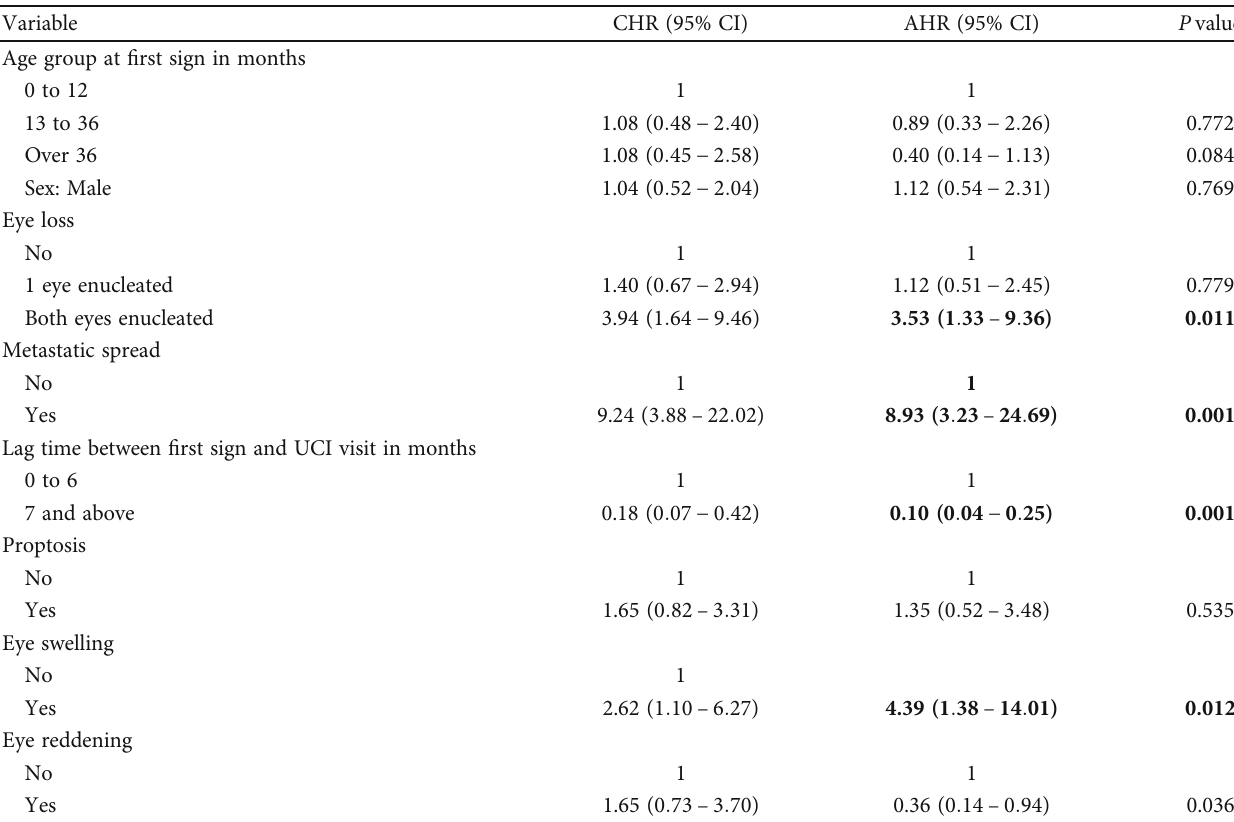
Figure 3: Graph showing the 3-year survival of children with retinoblastoma by metastasis. Table 4: Bivariate and multivariate Cox regression of selected demographic and clinical characteristics for predictors of survival among children with